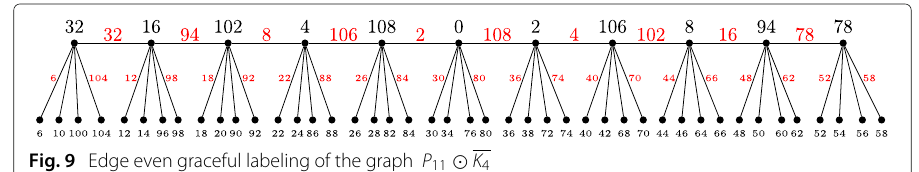
Fig. 9 Edge even graceful labeling of the graph P 11 (cid:4) K 4